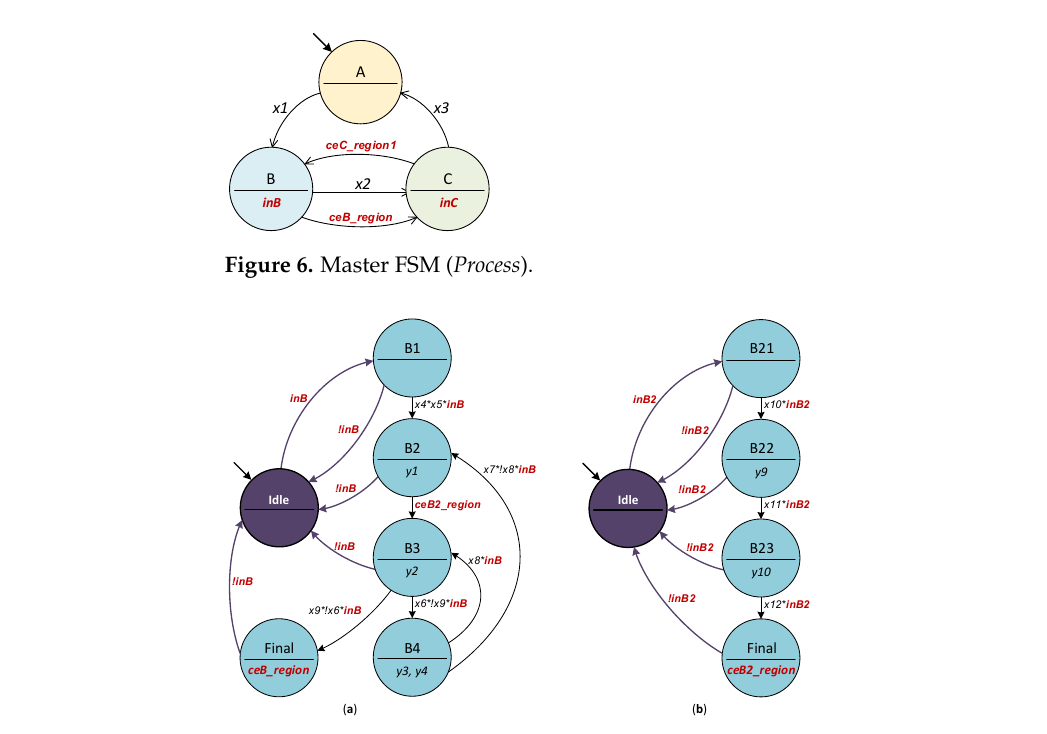
Figure 5. A state machine decomposition algorithm (in the form of a UML activity diagram).